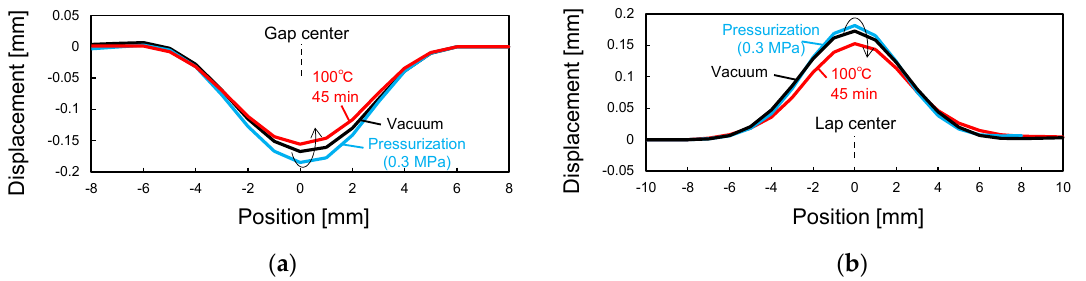
Figure 15. Shape calculated from curvature distribution. ( a ) Gap. ( b ) Lap.